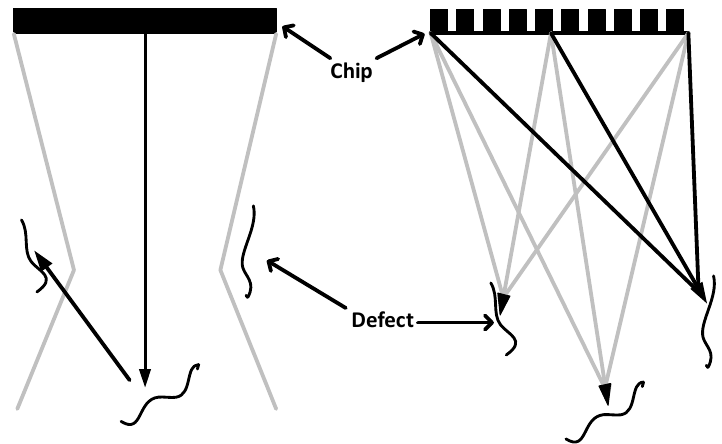
Figure 10. Principles of phased-array ultrasonic